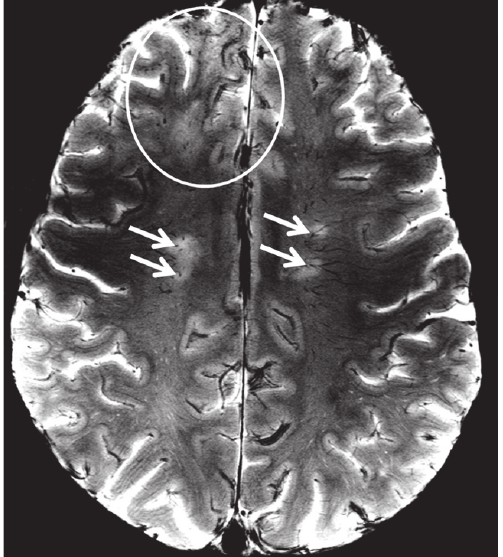
Figure 4: 7T T 2 ∗ weighted imaging in PML. A 7T T 2 ∗ weighted (T 2 ∗ w) image with a spatial resolution of (0.2 × 0.2) mm is shown. Please note the difference in lesion morphology between periventricular oval MS lesions that are centered on a small venous vessel (arrows) and confluent PML lesions (circle) that also involve U-fibers and subcortical areas.